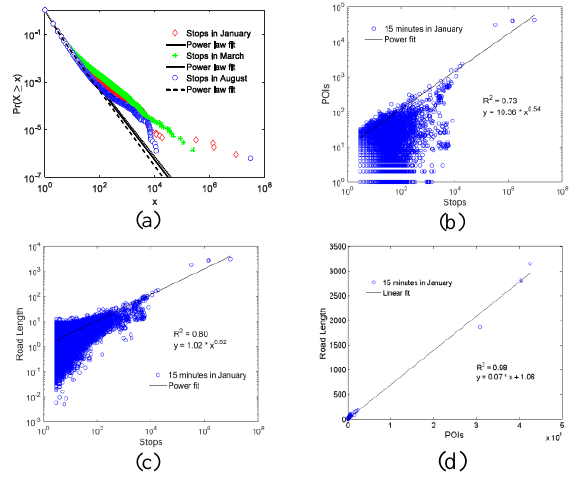
Figure 2. Scaling patterns of natural urban places